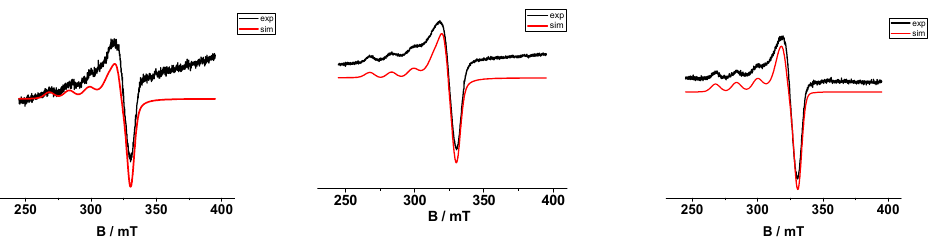
Figure 5. EPR spectra of 1 , 4 and 5 measured in DMSO solutions at 77K. Simulated spin Hamiltonian